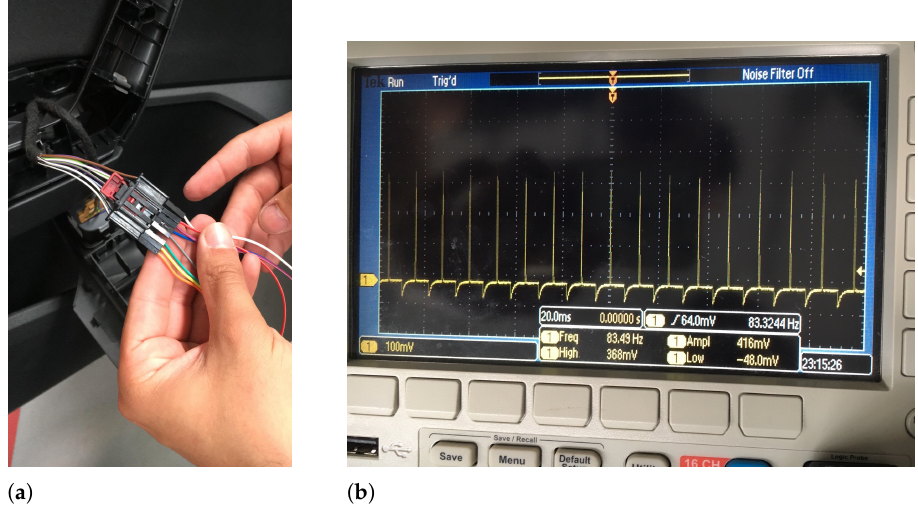
Figure 13. Electrical connections performed for measuring the electrical communications signals between the sensor and ECU in ( a ). ( b ) illustrates the measured signal with no action being applied by the